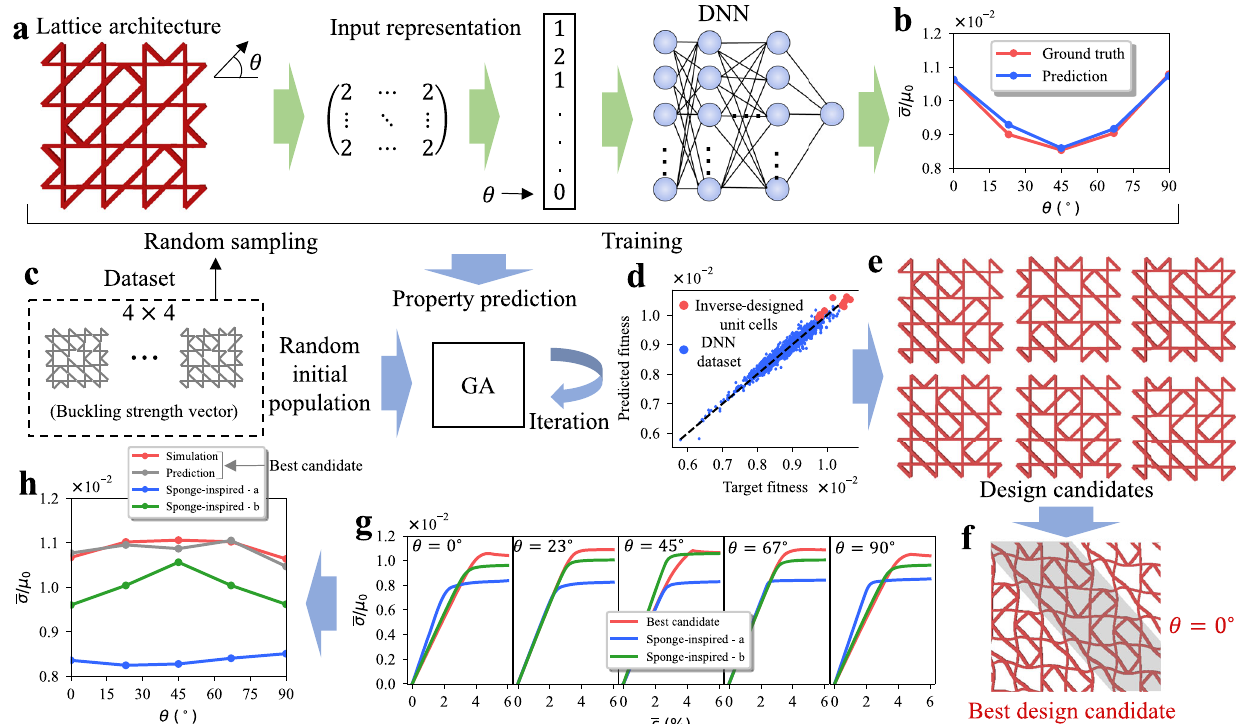
Fig. 2 Inverse design of buckling-resistant lattice materials. a Schematic information fl ow during property (buckling strength) prediction using DNN. b Example of predicted vs. target (ground truth) property of a generic non-uniform 4 × 4 unit cell. Lines are plotted only to facilitate the interpretation. c Dataset used for training and testing the DNN. d Predicted vs. target fi tness values for the whole dataset and for 12 inverse-designed architectures. e Best 6 design candidates output by the inverse-design algorithm. f Simulated post-buckled shape of the fi rst best design candidate loaded at θ = 0°. PBCs are imposed on a 10 × 10 super-cell. g Simulated stress-strain curves of the fi rst design candidate and sponge-inspired designs at fi ve different loading angles. h Normalized effective buckling strength of the fi rst design candidate at different loading directions compared to that of the sponge-inspired designs. Lines are plotted only to facilitate the interpretation. To compare the DNN predictions with the FE-simulated values, in g and h a single unit cell with PBCs is considered; a slight decrease in performance is exhibited due to global buckling effects, as shown in Supplementary Fig.